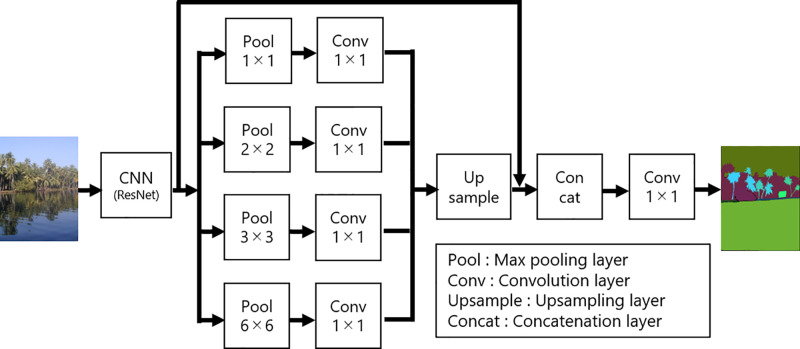
Overview of the flow in PSPNet [21].